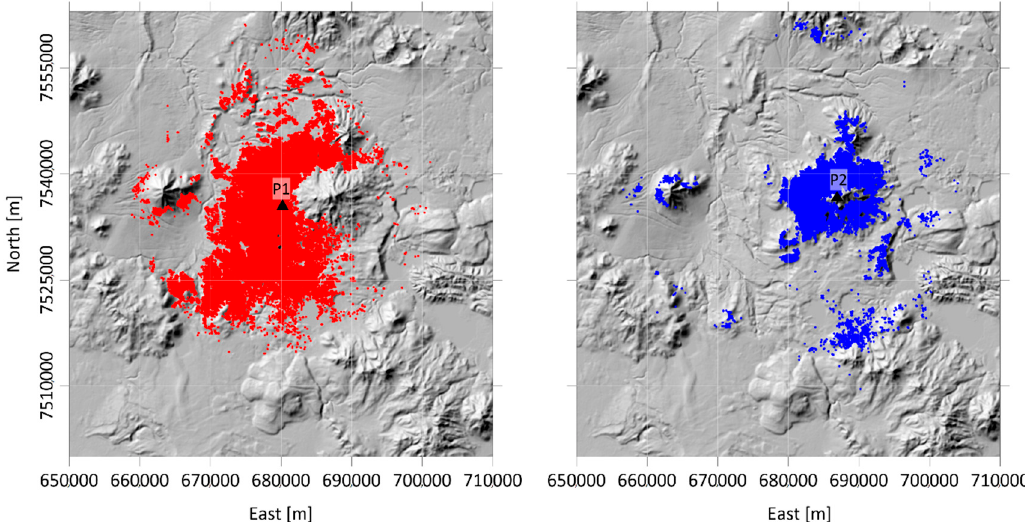
Figure 3. Spatial-temporal Cross-correlation analysis. Cross-correlation map: the red and blue points indicate coherent cluster pixels with respect to the deformation time-series at P1 and P2 pixel (black solid triangle, also reported in Figure 2c), respectively, during the 2005–2008 time interval; these points are characterized by a correlation coefficient greater than 0.97.